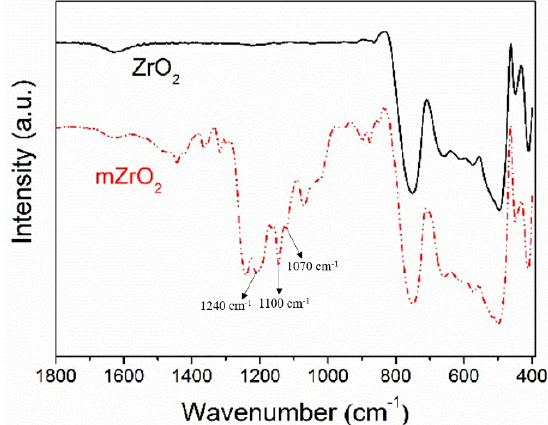
Figure 2. FT ‐ IR spectra of crude zirconia (ZrO 2 ) and surface fluoro ‐ modified zirconia (mZrO 2 ). The related peaks listed below: 1240–1100 cm –1 ( ν s, C–F on PFAS) and 1070 cm –1 ( ν as, Si–O linked with ZrO 2 ).